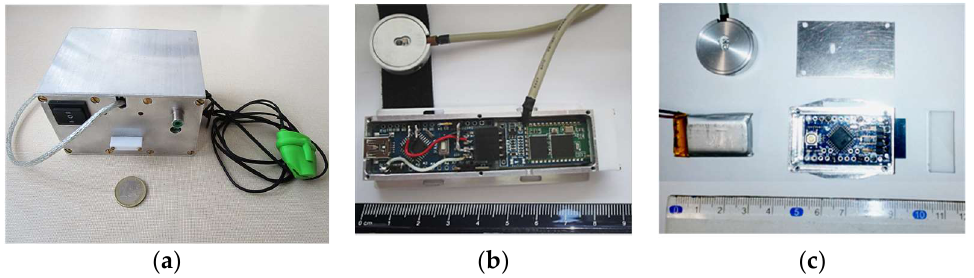
Figure 7. Assemblage with aluminum covering of: ( a ) prototype of the PPG-EP sensor, ( b ) the body and optical part of the PPG-PS1 sensor, ( c ) the body, optical part of the PPG-BLE sensor, and the Li-Po battery used for power supply.